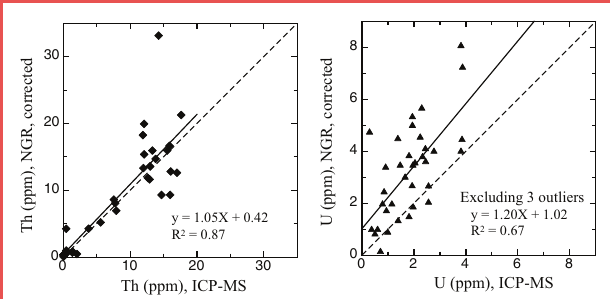
Figure 3. Total U and Th concentrations measured by ICP-MS vs. density-corrected U and Th concentrations measured by NGR for the 38 samples from 4 sites in the South Pacific Gyre that were analyzed for this study. Three outliers were removed from the U graph and are discussed in the section about secular